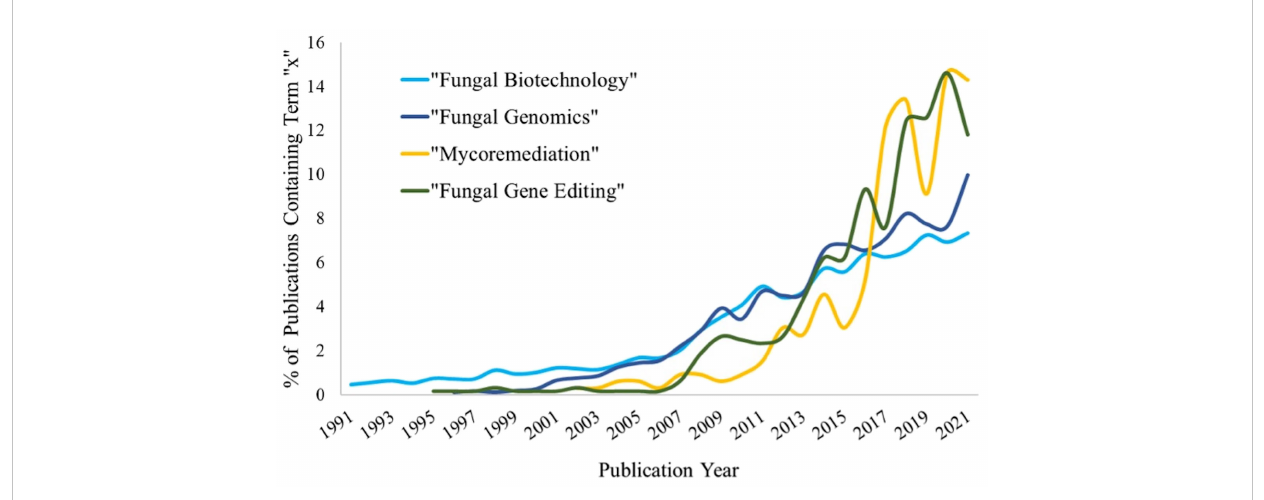
FIGURE 1 Representation of publication trends for given terms between 1991-2021. Publication numbers represent all documents found within the given years by Web of Science